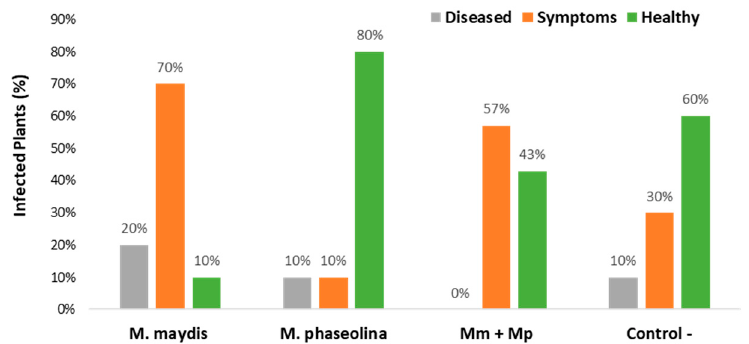
Figure 5. Maize wilt assessment carried out 79 days after sowing. Wilting percentages of the 2019 experiment described in Figure 2 were determined 21 DAF. Plants were classified as “healthy” when no apparent signs of dehydration could be identified and as “symptoms” when the upper leaves’ color started to alter to light-silver and then to light-brown, rolling inward from the edges of the leaf. When the whole plant was presenting severe dehydration with light-brown color spreading to all of its parts and its cobs tilted down, it was classified as “diseased.” Percentages are the mean of 10 replications.